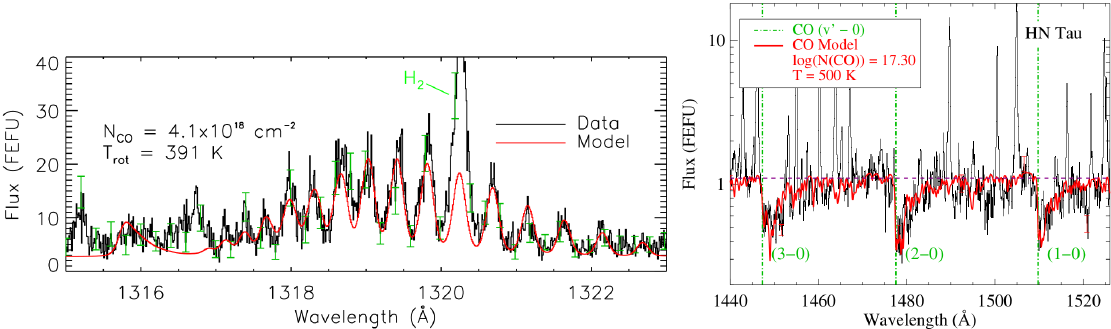
Figure 7. Left : Fourth positive band emission of CO from Schindhelm et al. [31]. Right : CO absorption in the CTTS HN Tau. Data shown in black, fit of the CO transmission spectrum in red, and the green line indicates the bandheads (1 FEFU = 10 − 15 ergscm − 2 s − 1 Å − 1 ). From France et al. [32]. Both figures: c AAS. Reproduced with permission. (cid:13)